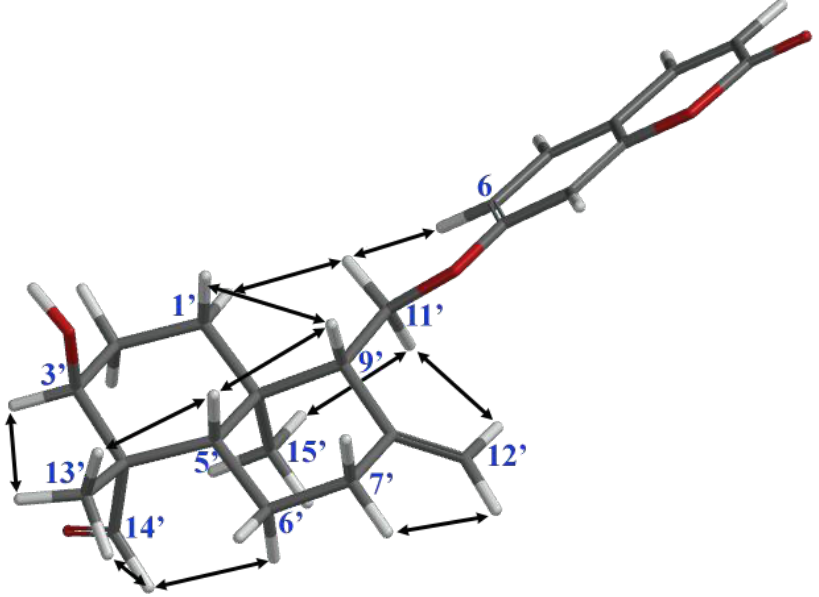
Figure 3. NOE interactions observed in the 2D NOESY spectrum of anatolicin ( 8 ) [15] .